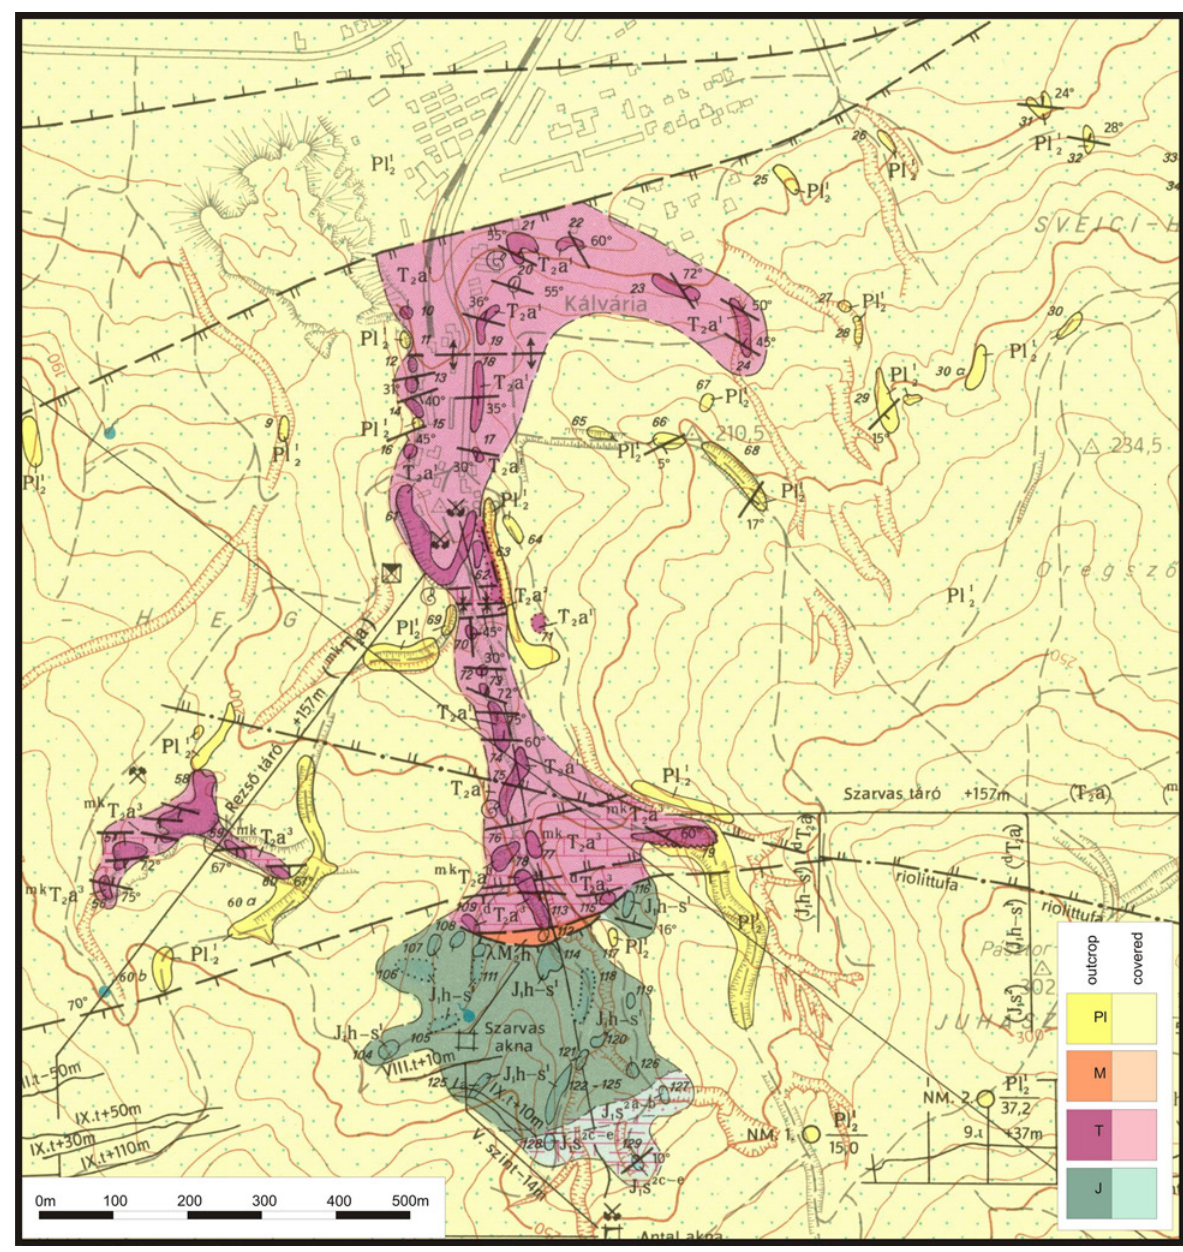
Fig. 2. Geological map of Nagymányok area (Hámor et al. 1966). Legend: Pl 21 – limonitic sand and sandtone; M – miocene rhyolite tuff; T – generally anisian dolomitic limestone, limestone; J – jurassic coal and (clayey)